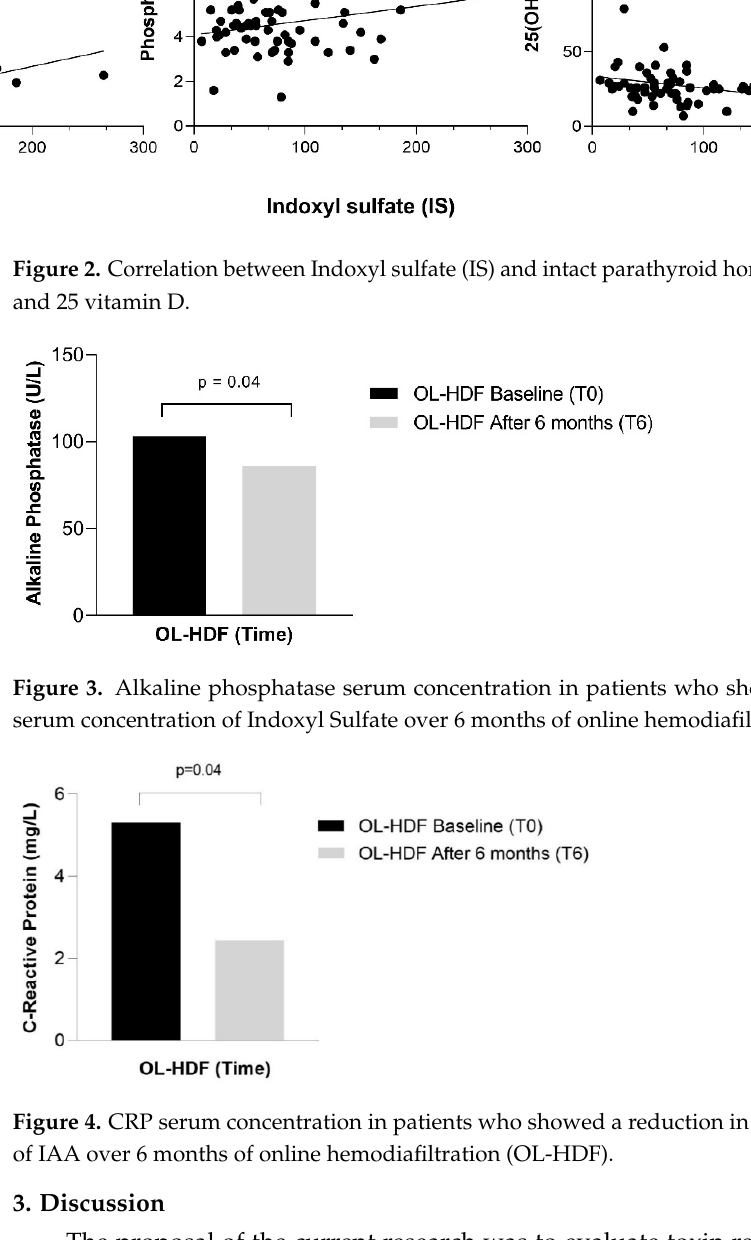
Figure 4. CRP serum concentration in patients who showed a reduction in the serum concentration of IAA over 6 months of online hemodiafiltration